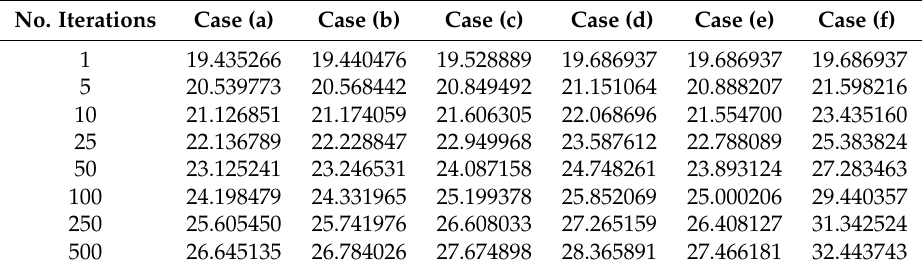
Table 1. The values of PSNR of six cases in Theorem 2 at x 1 , x 5 , x 10 , x 25 , x 50 , x 100 , x 250 , x 500